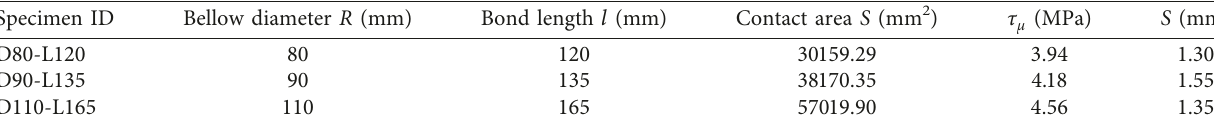
Table 3: Peak values of bond stress and the corresponding slippage of different contact areas.